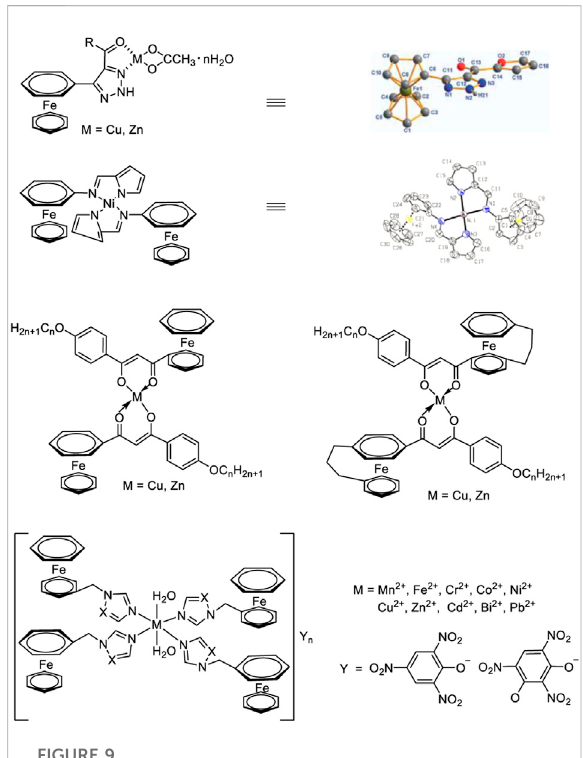
FIGURE 9 Some ferrocene derivatives (Zhuo et al., 2015; Zhao et al., 2013; Zhao et al., 2015; Jiang,